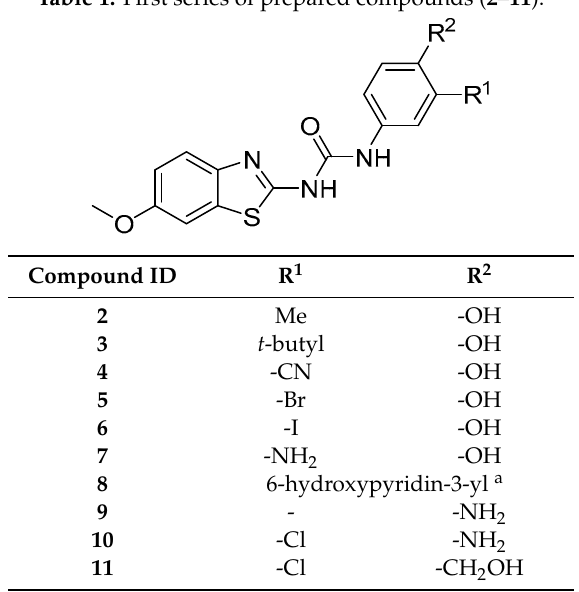
Figure 2. Design of benzothiazolylurea-based 17 β -HSD10 inhibitors.